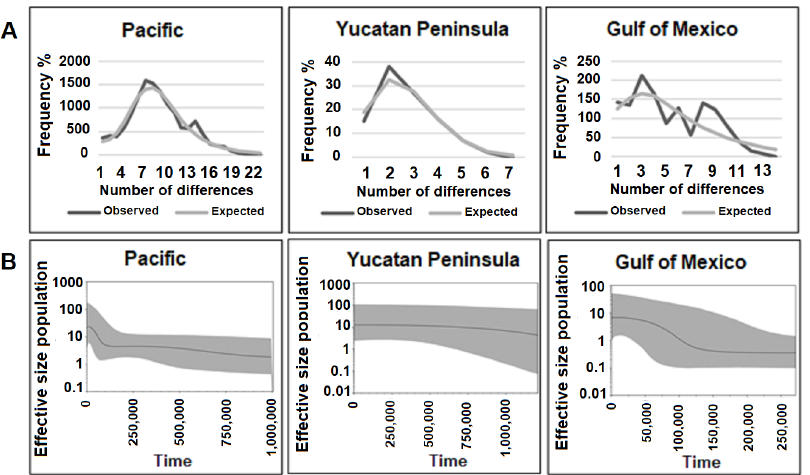
Figure 3. ( A ) Mismatch distribution and ( B ) extended Bayesian skyline plot from Pacific, Yucatan Peninsula and Gulf of Mexico.